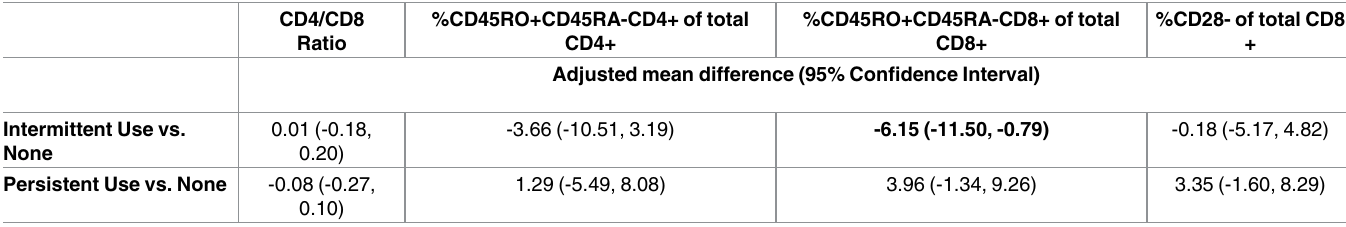
Table 4. Association between pattern of illicit opioid use and CD4/CD8 ratio and memory cells, linear regression models *